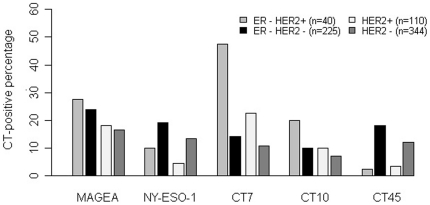
Distribution of CT antigen expression percentages in HER2 positive and HER2 negative breast cancer.Comparisons were carried out for each CT antigen between the ER-HER2+ and the ER-HER2- (triple-negative) cases and between all HER2+ and HER2- cases. Significant differences were found for both comparisons for CT7 and CT45 only (P≤0.01), with CT7 more frequently expressed in HER2-positive tumors, whereas CT45 more frequently in HER2-negative tumors.